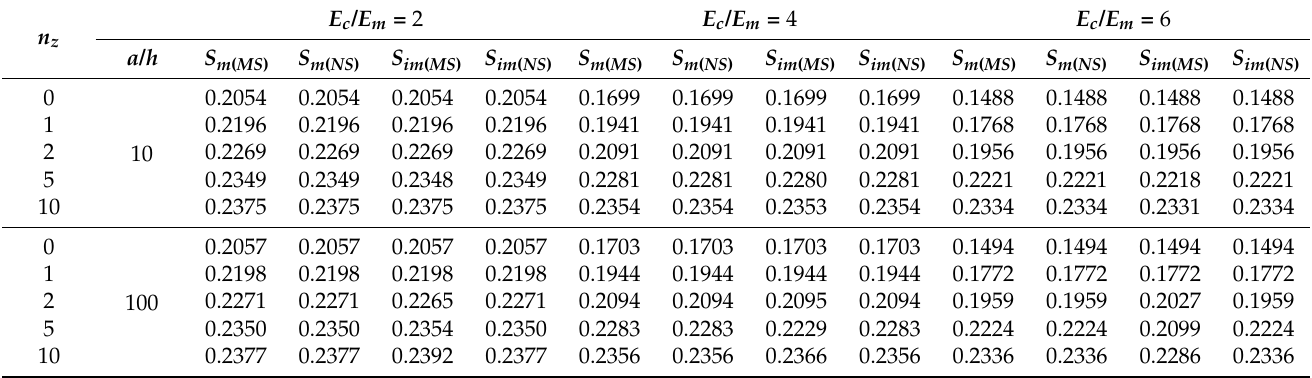
Table 7. Non-dimensional stress τ xz of BDFG square movable ( m ) and immovable ( im ) simply supported plates subjected to sinusoidal load based on middle surface formulation ( MS ) and